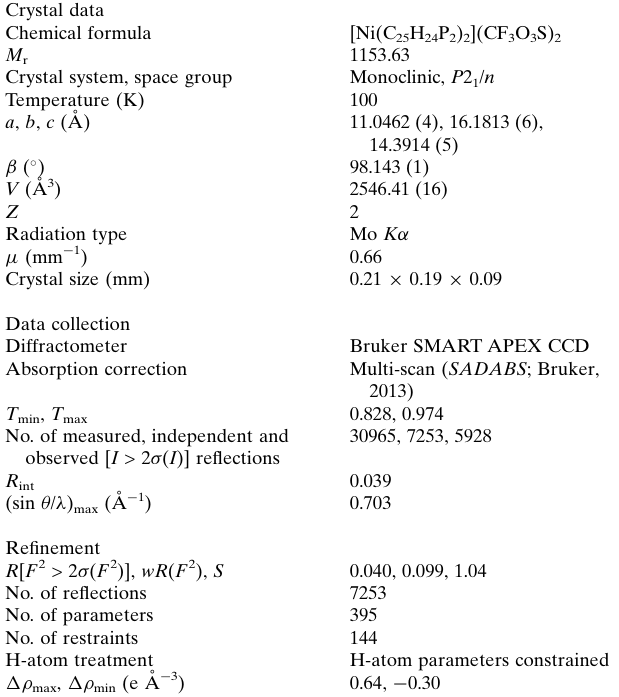
Table 2 Experimental details. Crystal data Chemical